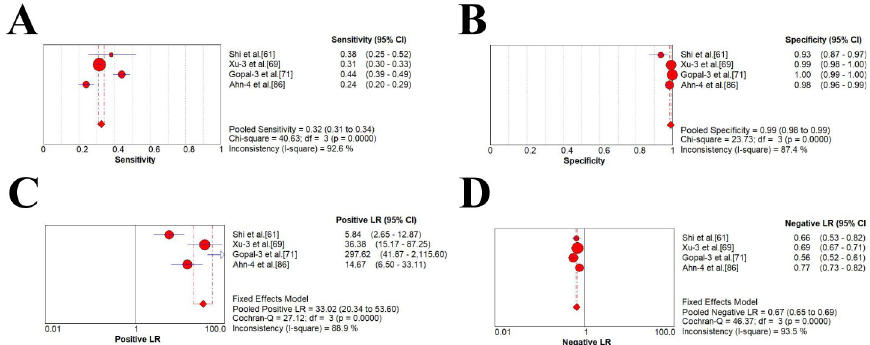
Fig 4. Forest plots of the estimates for AFP in HCC diagnosis (400 ng/mL). (A) Pooled sensitivity. (B) Pooled specificity. (C) Pooled positive LR. (D) Pooled negative